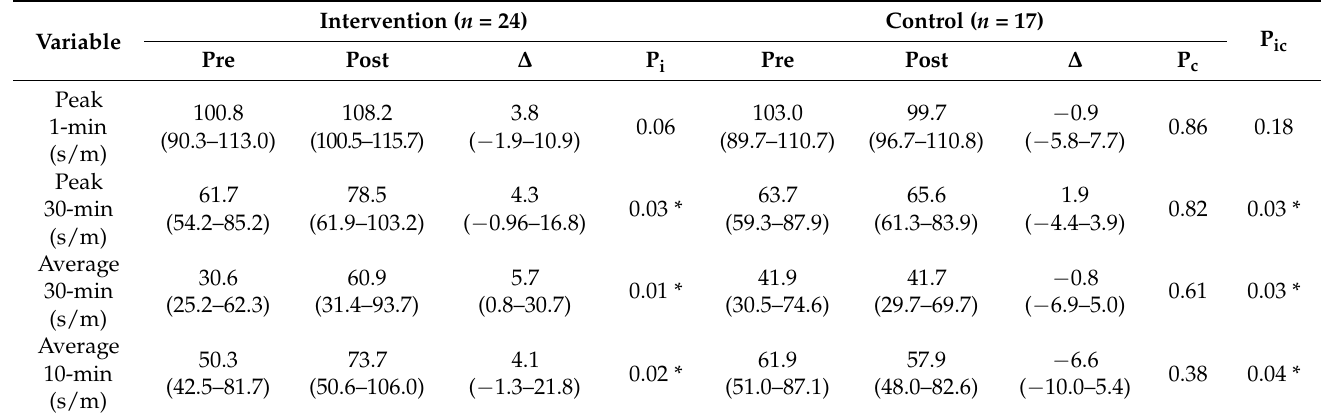
Table 5. Quality of ambulatory behavior: peak and average cadence.